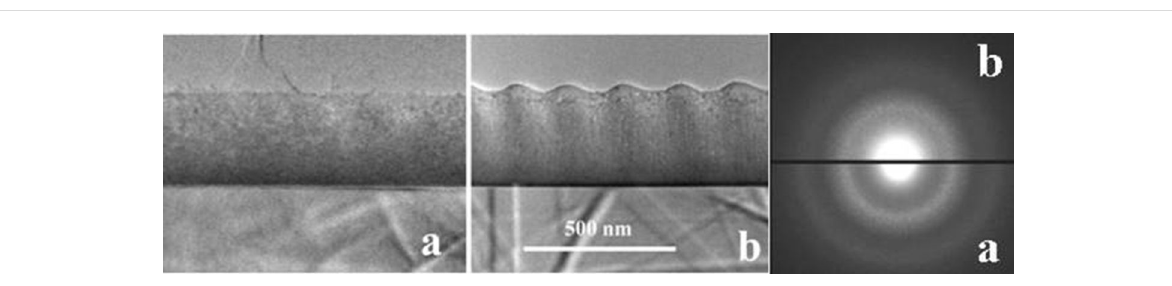
Figure 2: Low-magnification XTEM images of the amorphous GeTiO film, before (a) and after (b) laser irradiation at low fluence (15 mJ/cm 2 ). A small, but evident, increase of the film volume happens. The film structure remains amorphous after laser irradiation, as can be seen from the corres- ponding SAED patterns.